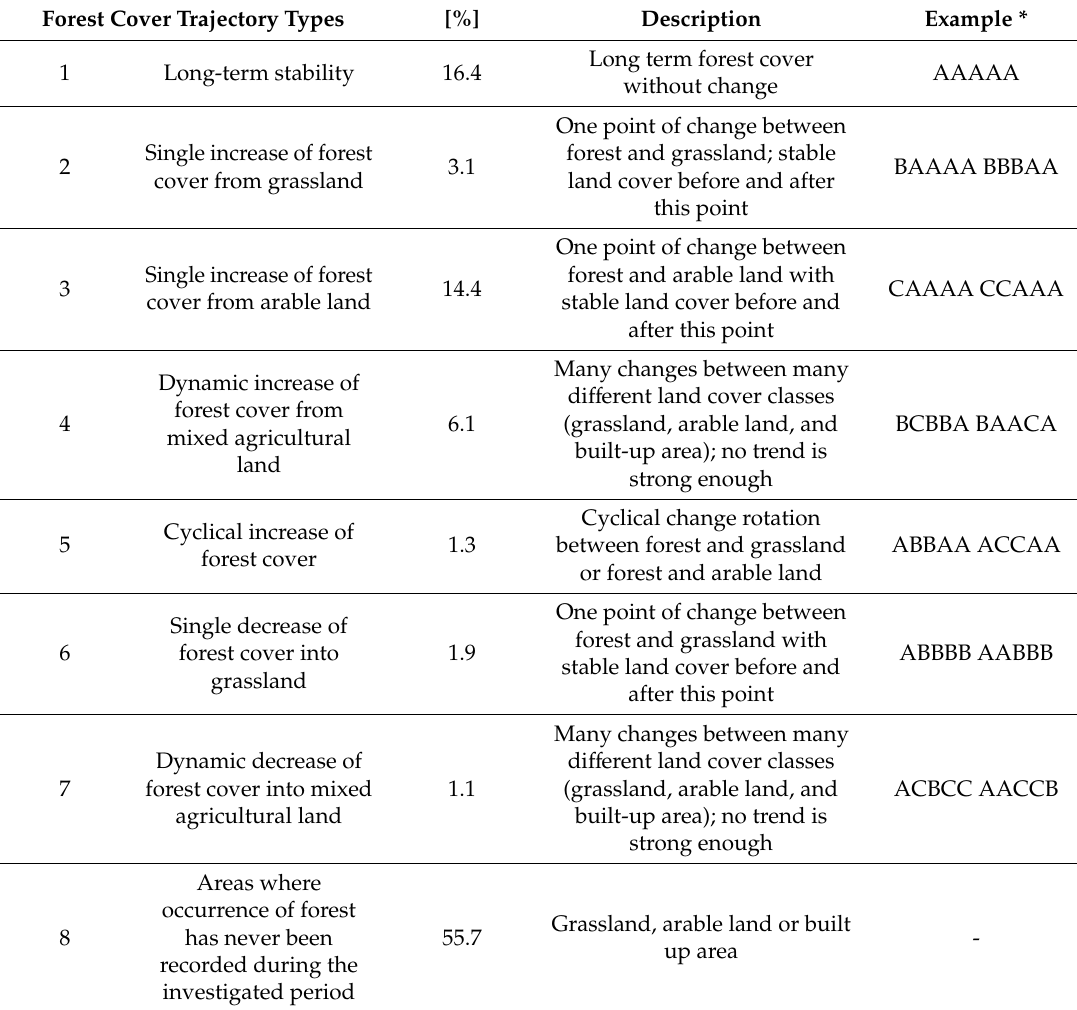
Table 2. Forest cover change trajectory